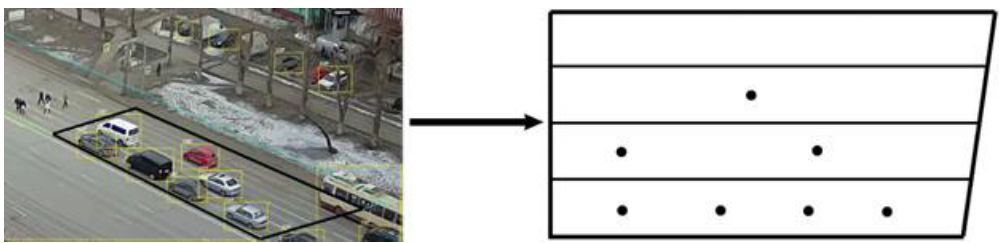
Figure 3. Matrix of perspective transformation to determine the time spent by the vehicle within the control zone, where a i is the coordinates of a specific vehicle; d i is the distance between two points; and t i is the time between frames.